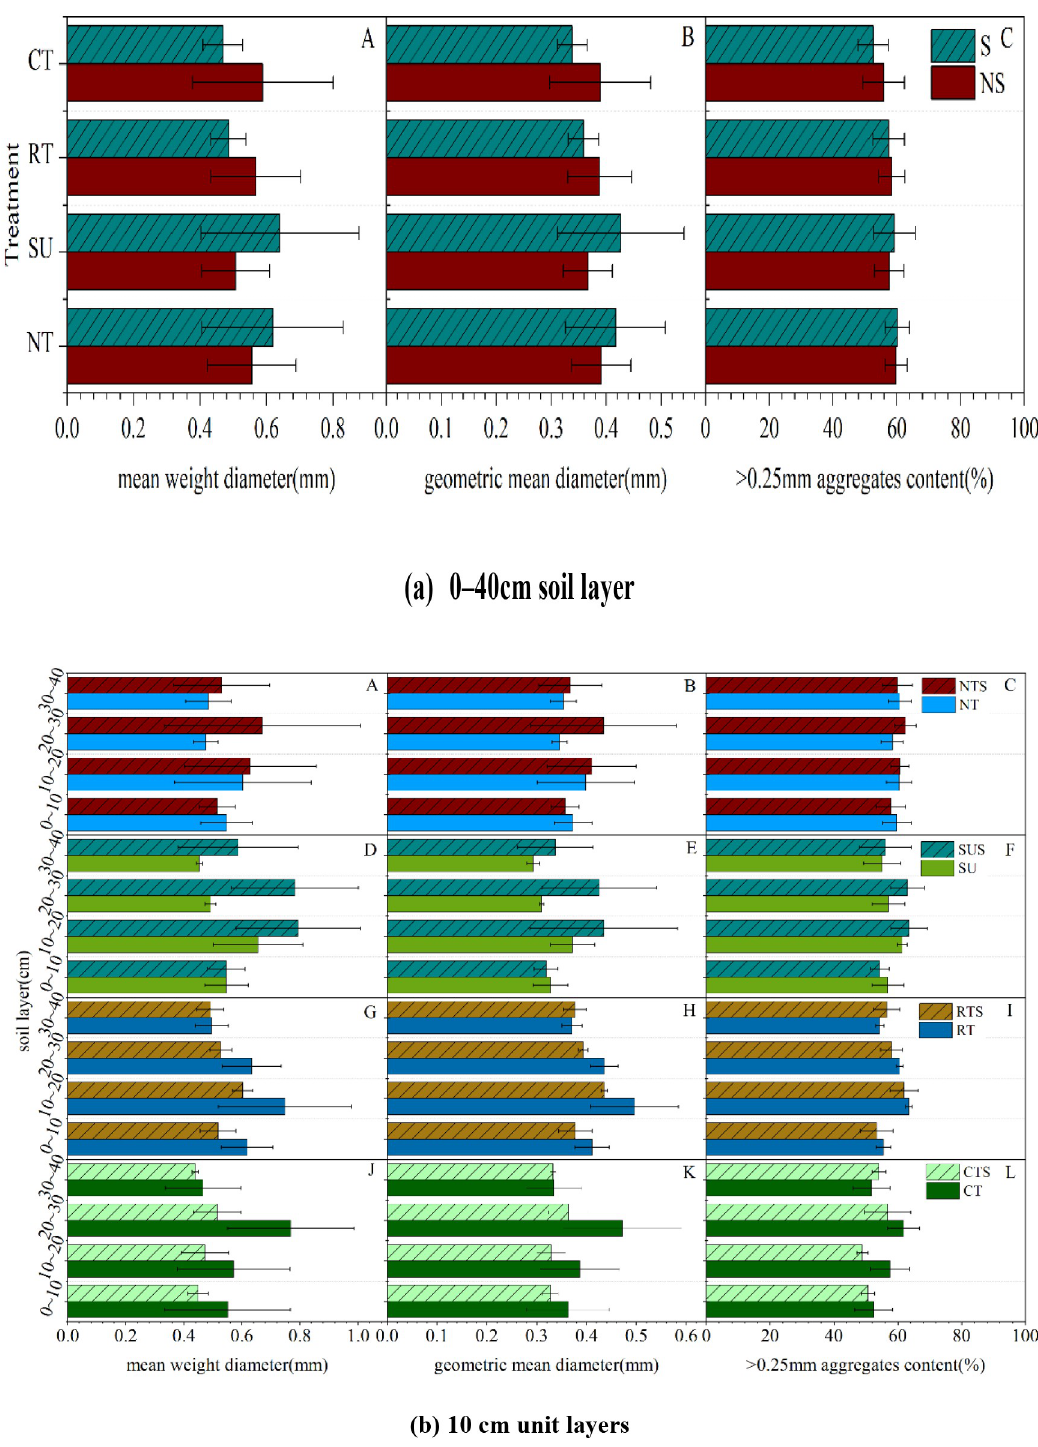
Fig 3. Comparison of the effects of straw return on MWD, GMD, and R 0.25 under the same tillage cultivations. Note: S, straw return; NS, straw removal.